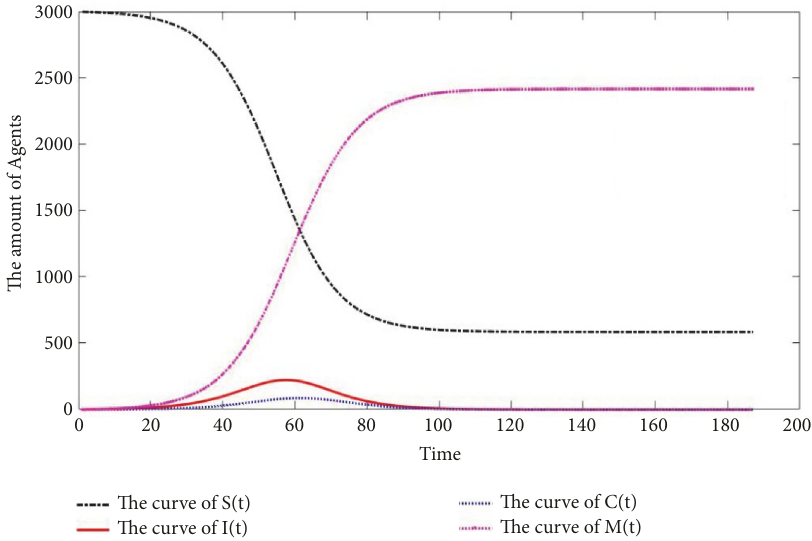
The curve of S(t) The curve of I(t) Figure 6: The evolutionary characteristics of risk contagion after increasing 𝑥 4 (Case 5).